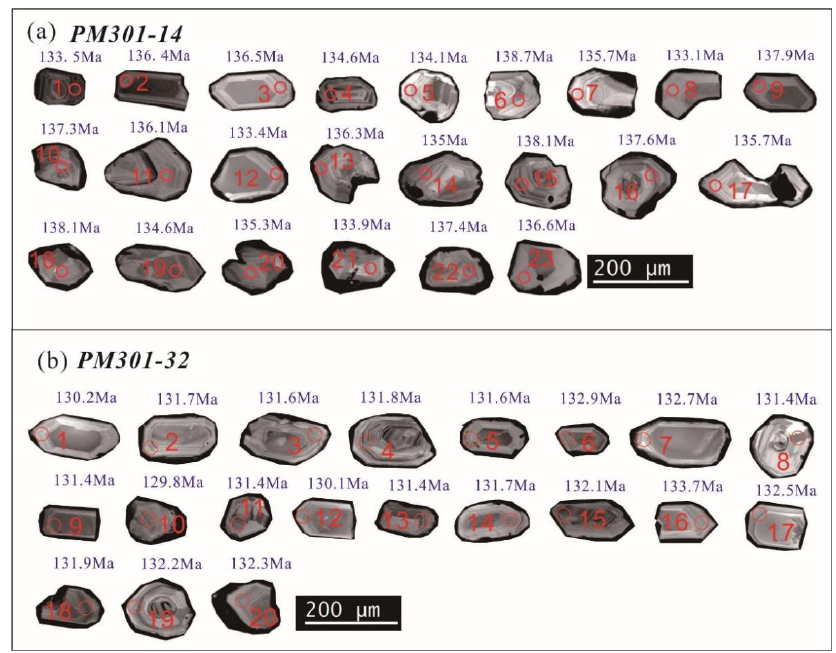
Figure 5. Representative zircon grains from rhyolitic tuff samples (PM302-14 and PM302-32), showing the spot location of laser ablation and 206 Pb/ 238 U apparent ages.